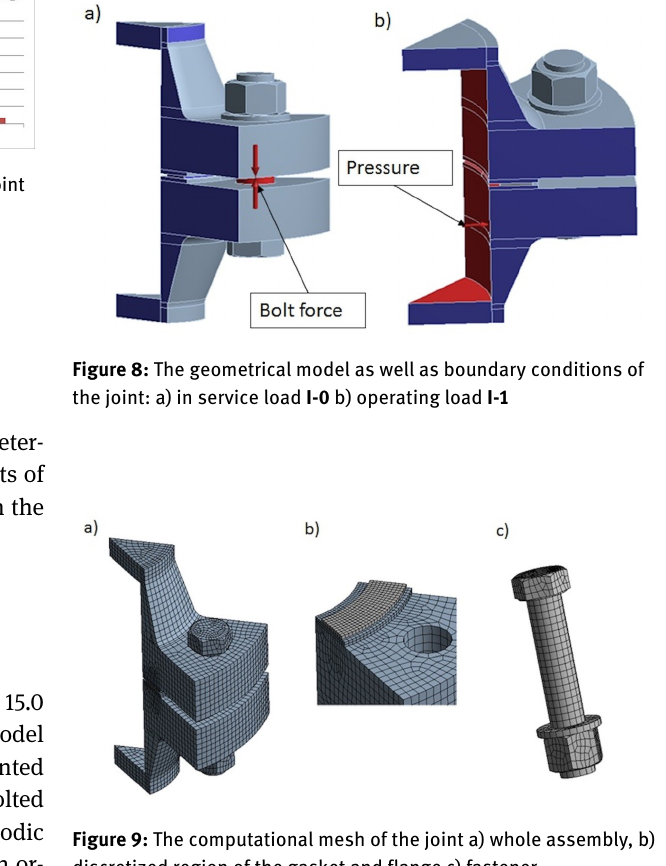
Figure 9: The computational mesh of the joint a) whole assembly, b) discretized region of the gasket and flange c)